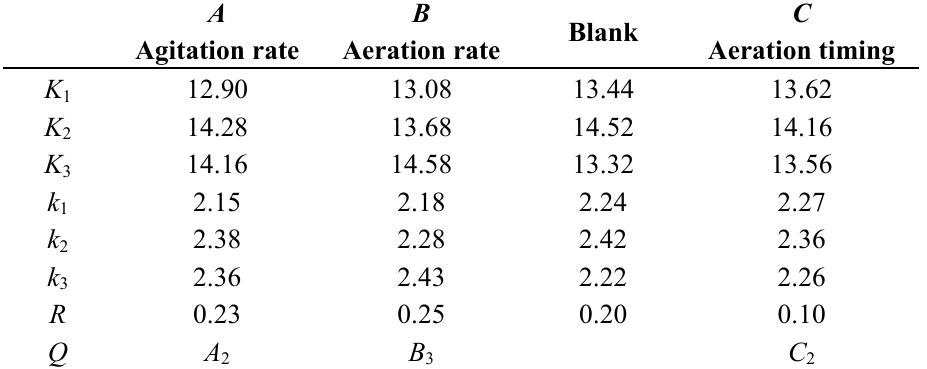
Table 6. The range analysis of L